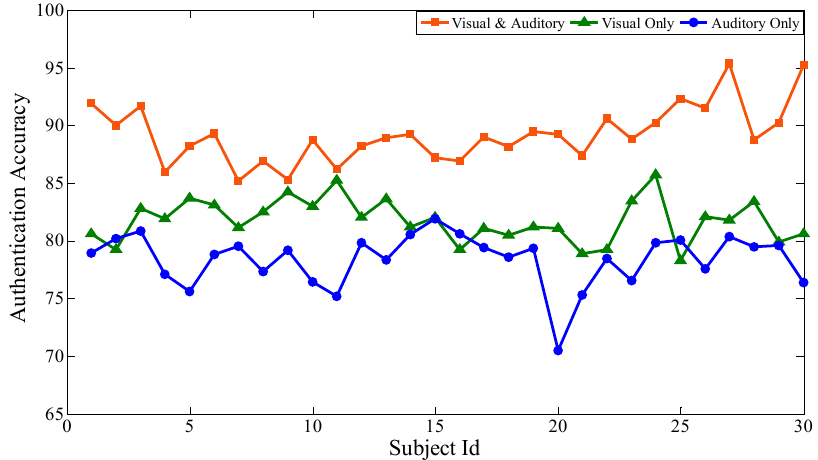
Sensors 2019 , 19 , x FOR PEER REVIEW Figure 9. Comparison of average classification accuracy of the three paradigms.